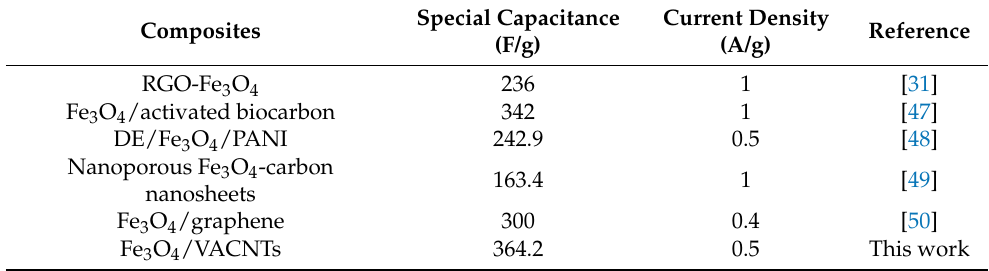
Table 1. Comparison of the electrochemical performance with other nanocomposites based on Fe 3 O 4 .